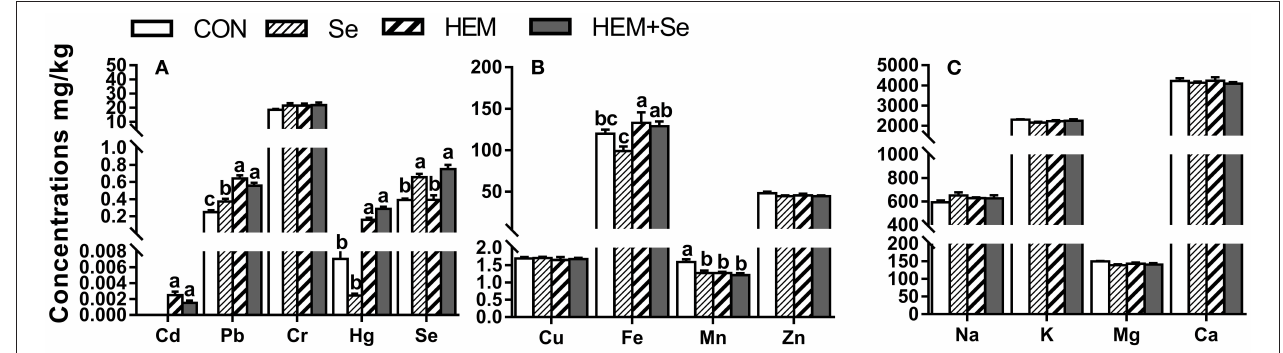
FIGURE 1 | The effect of selenium and cadmium, lead, mercury, and chromium Co-treatment on the concentrations of ions in the egg yolk (Wet Basis mg/kg) of laying hens from 63 to 74 wk of age. CON, corn-soybean meal basal dietary; Se, the basal dietary supplemented with 0.4 mg/kg selenium from selenized yeast (the selenium concentration was 0.14 mg/kg in the CON diet); HEM, the basal dietary supplemented with 5 mg/kg cadmium from CdCl 2 , 50 mg/kg lead from Pb(NO 3 ) 2 , 3 mg/kg mercury from HgCl 2 and 5 mg/kg chromium from CrCl 3 ; HEM + Se, the HEM dietary supplemented with 0.4 mg/kg selenium from selenized yeast. (A) The effect of selenium and cadmium, lead, mercury, and chromium Co-treatment on the concentrations of cadmium, lead, chromium, mercury, and selenium in the egg yolk. (B) The effect of selenium and cadmium, lead, mercury, and chromium Co-treatment on the concentrations of copper, iron, manganese, and zinc in the egg yolk. (C) The effect of selenium and cadmium, lead, mercury, and chromium Co-treatment on the concentrations of sodium, potassium, magnesium, calcium in the egg yolk. a,b,c Bars without a shared common letter are significantly different ( p < 0.05). Data show the mean ± SEM ( n = 10).